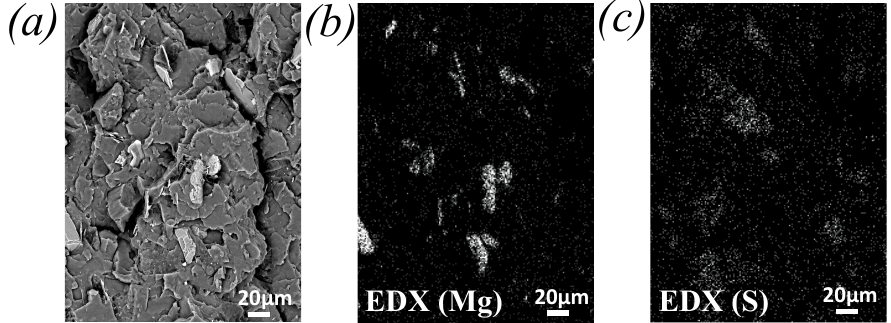
Figure 6. ( a ) SEM images at a magnitude 300 × of fracture surface of PLA/GTR a 15 wt% sieved 230’s mesh and obtained after uniaxial tensile test up to failure, ( b ) mapping of the magnesium element (Mg) dispersed into the PLA matrix obtained from chemical analysis by EDX and ( c ) mapping of the Sulphur element (S) indicative of the GTR location obtained from chemical analysis by EDX.